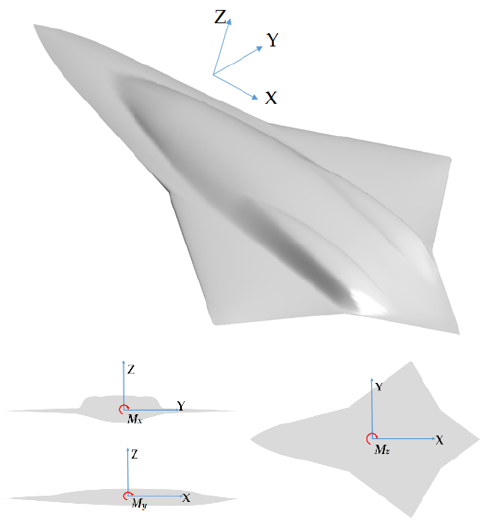
Figure 1. The coordinate system and sign convention for the research